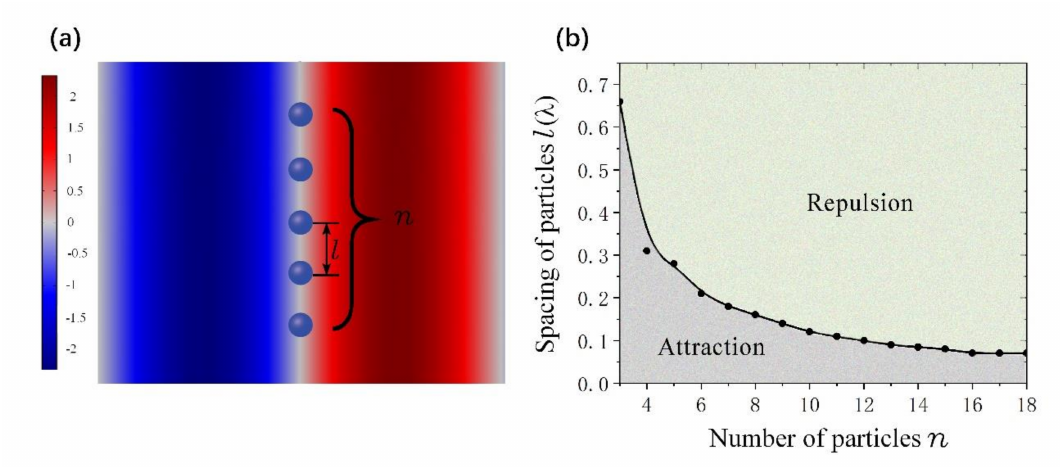
Figure 7. ( a ) The schematic for acoustic interaction between massive equidistant particles. ( b ) The phase diagram of the critical distance for the particle closest to the center.